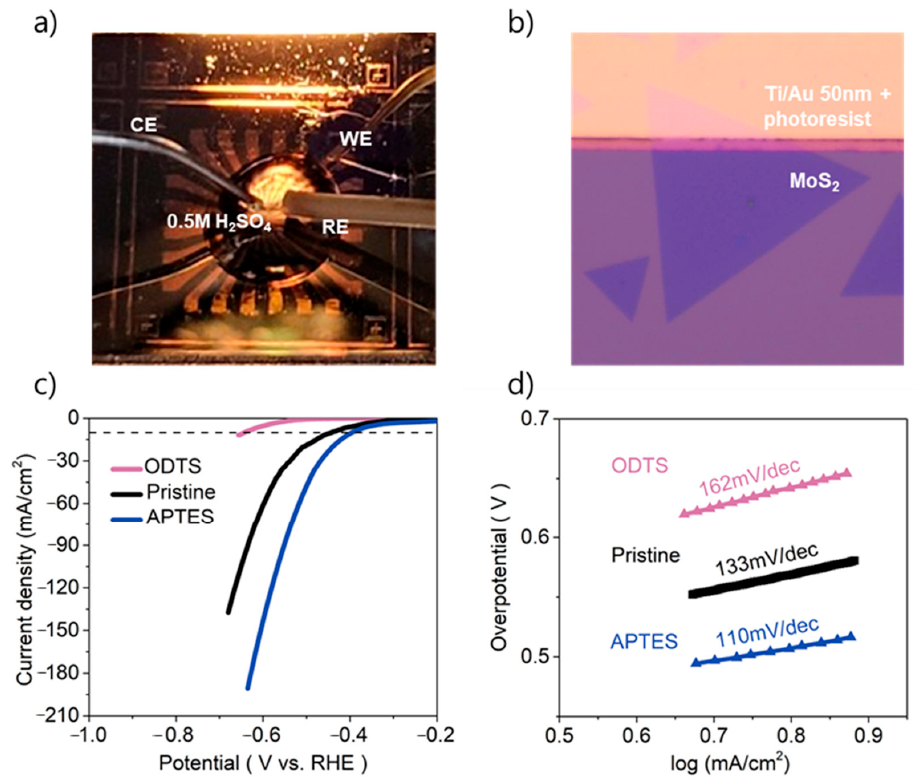
Figure 4. Electrochemical setup for measuring the HER activity of the MoS 2 monolayers. ( a ) Photograph of the electrochemical device. ( b ) An optical microscope image of the electrochemical device. The Ti/Au electrode was covered by photoresists to make it inert to catalytic activities. ( c ) Polarization curves and ( d ) Tafel plots measured for pristine and surface-functionalized MoS 2 monolayers.